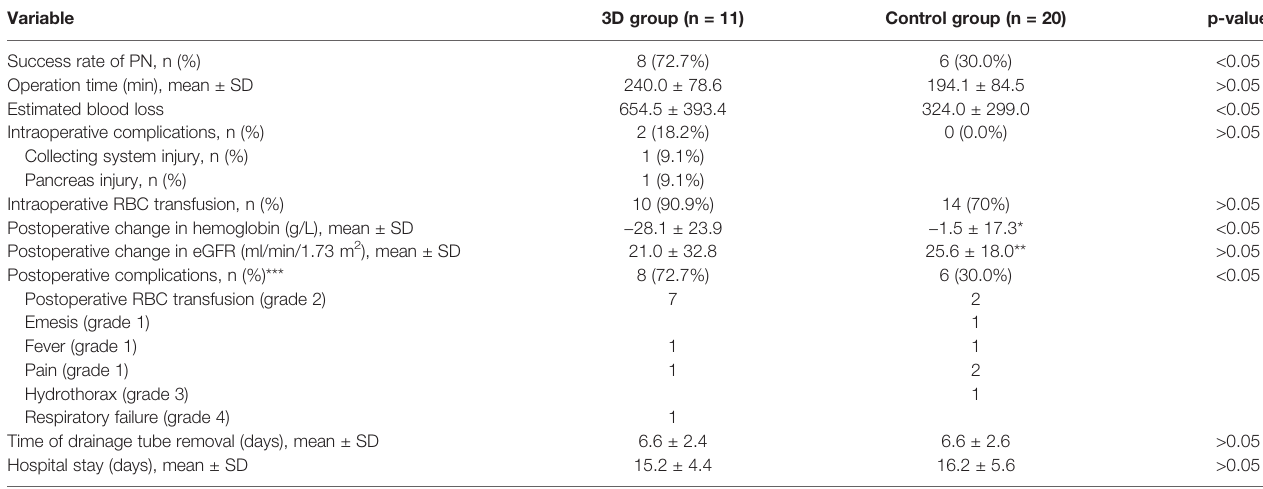
TABLE 3 | Perioperative parameters and clinical outcomes.